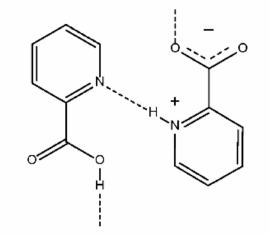
H o m , T ∆ S o m and ∆ G o m for fenclorim and clopyralid in both gaseous f f f